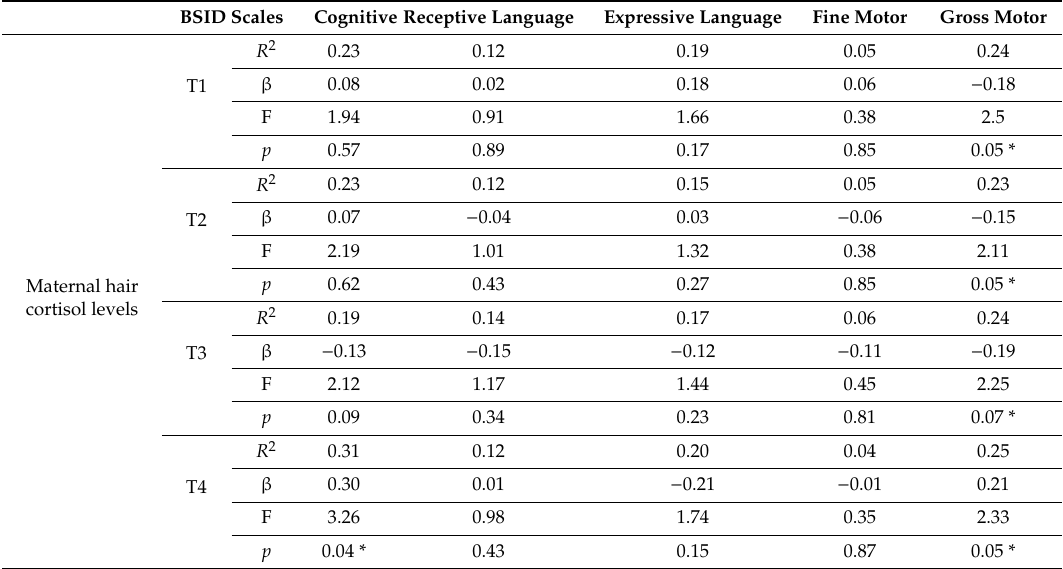
Table 3. Hierarchicalregressionsusingmaternalhaircortisollevelsaspredictorsofinfantneurodevelopment. BSID Scales Cognitive Receptive Language Expressive Language Fine Motor Gross